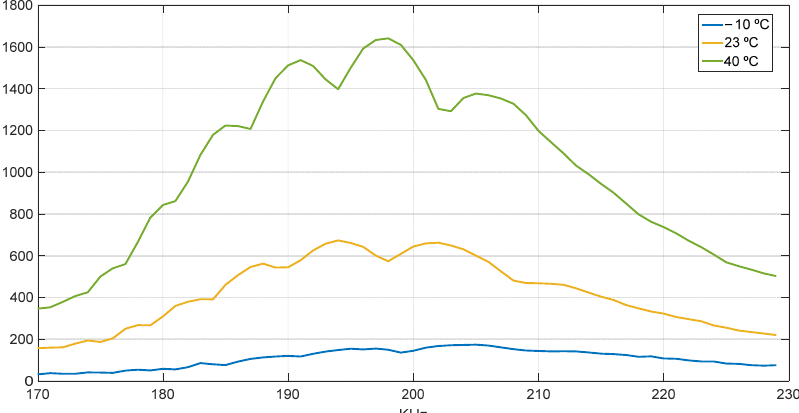
Figure 20. Amplitude received at different temperatures.